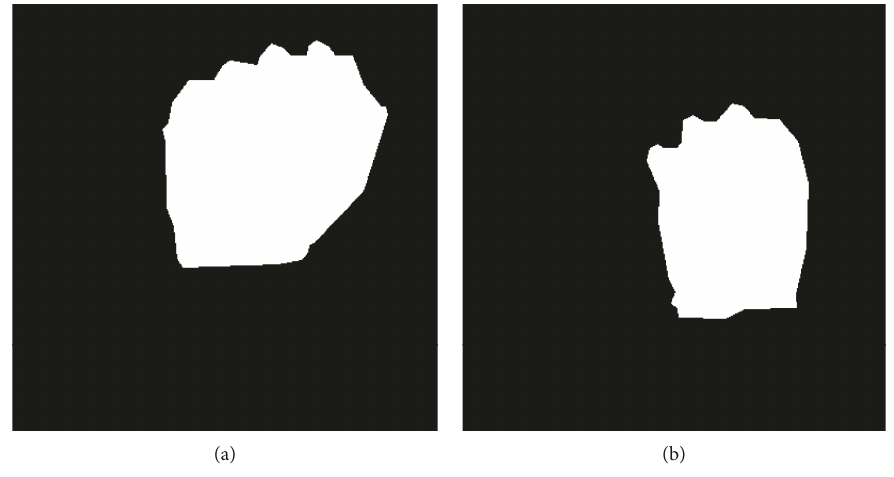
Figure 10: Similar segmented images: gestures A (a) and E